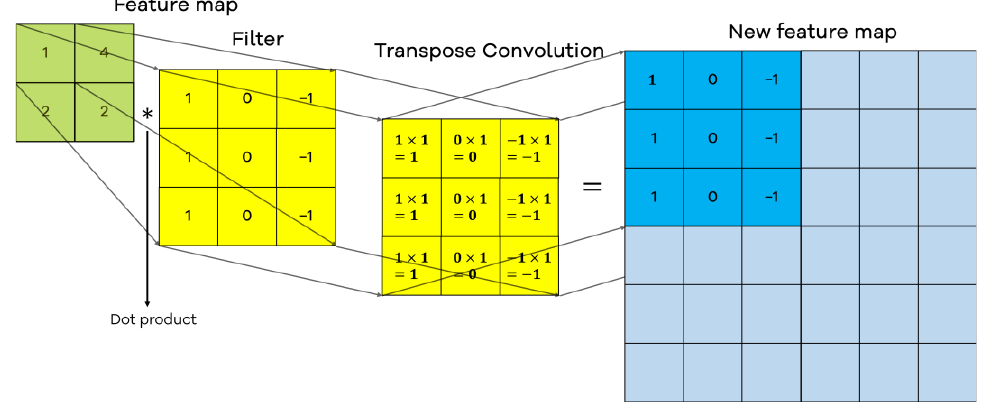
Figure 6. Transpose convolution.